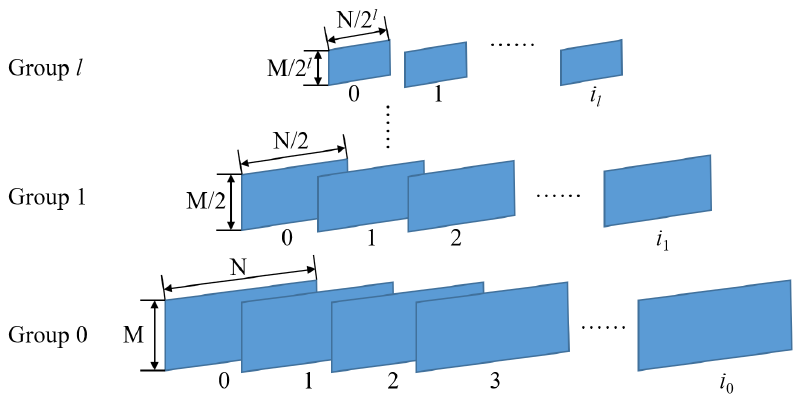
Figure 4. Gaussian pyramid in multi-scale LSD.